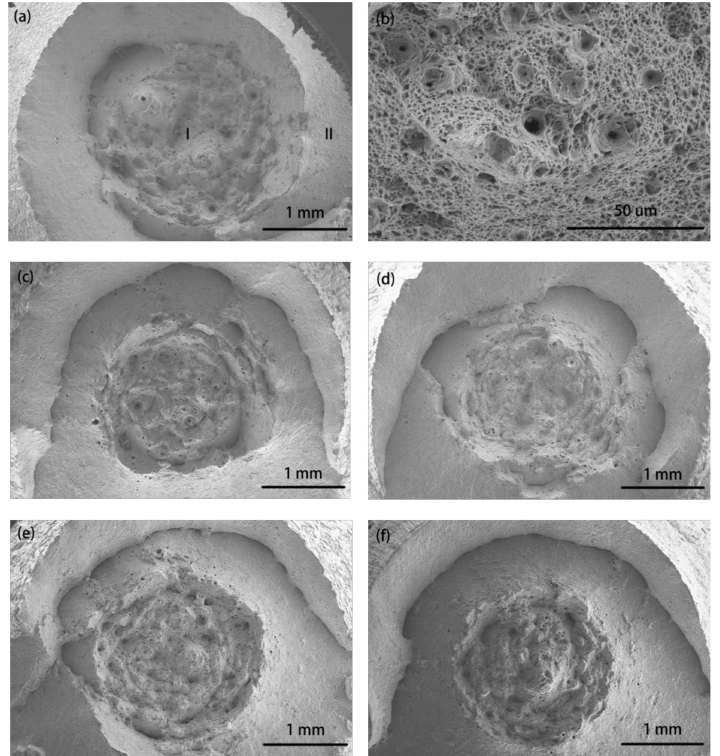
Figure 5. SEM observations of fractured surfaces: ( a ) static creep and ( b ) enlarged inner fibrous zone; ( c ) cyclic creep at 12 and ( d ) 39 MPa / s unloading rate without valley stress duration; ( e ) cyclic creep with 10 and ( f ) 30 min duration under valley stress with an unloading rate of 12 MPa /